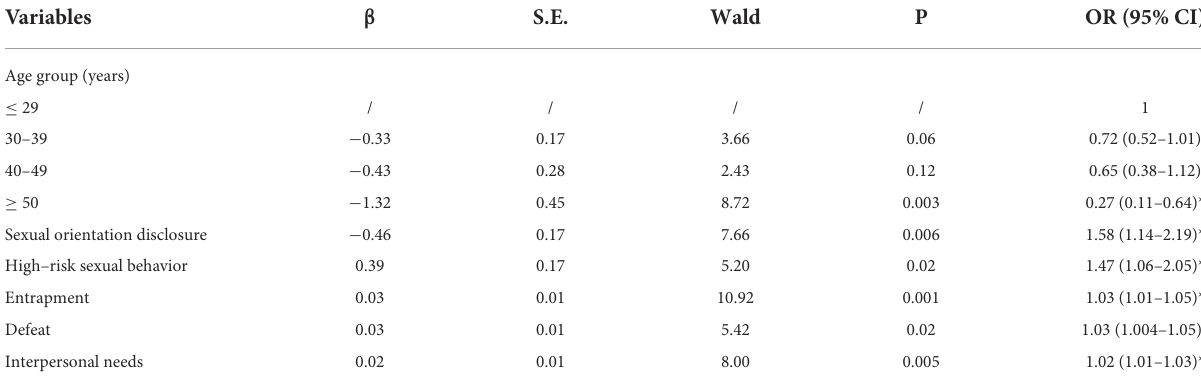
TABLE 5 Risk factors of SI selection using multivariate logistic regression ( n = 882).